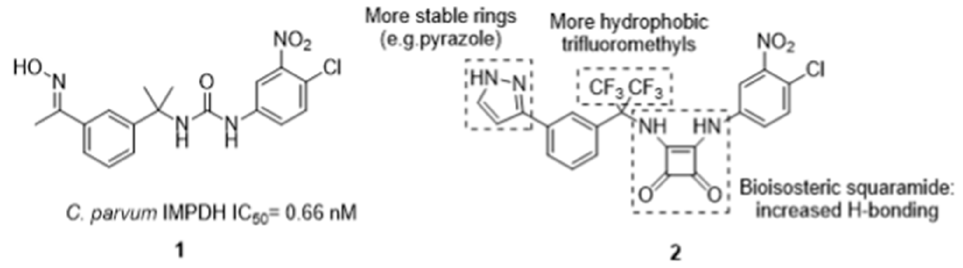
12 of 59 Figure 7. Computational design of endogenous agonist-bound GCG/GIP/GLP-1 receptors in com- plex with heterotrimeric Gs proteins, composed of G α , G β , and G γ subunits. 3.5. Design and Synthesis of Novel Drugs for the Treatment of Cryptosporidiosis Amit Upadhyay 1,2 and Timothy P. O’Sullivan 1,2,3 1 School of Chemistry, University College Cork, T12 K8AF Cork, Ireland; 119222561@umail.ucc.ie 2 Analytical and Biological Chemistry Research Facility, University College Cork, T12 K8AF Cork, Ireland 3 School of Pharmacy, University College Cork, T12 K8AF Cork, Ireland Despite being one of the most widespread diarrheal diseases, there are no effective treatments available for cryptosporidiosis, which is caused by an oocyst-forming proto- zoan, Cryptosporidium [43]. Severe illness resulting from Cryptosporidium infection can be life-threatening, especially in young children and people with weak immunity such as patients with HIV [44]. Cryptosporidiosis outbreaks have been reported in countries all